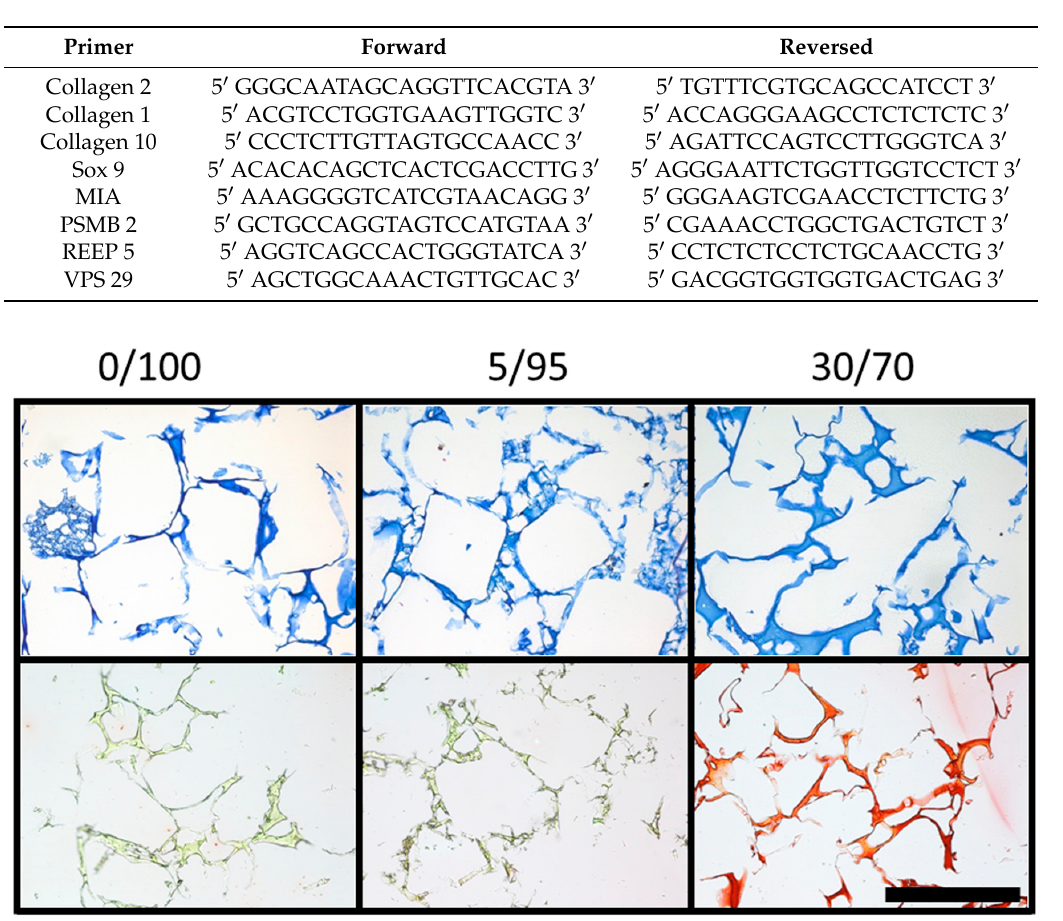
Figure A1. DMMB and picrosirius red staining of empty scaffolds of different composition (columns): DMMB staining for glycosaminoglycans (e.g., HA) at ×10 magnification (upper row) and picrosirius red staining for collagen (e.g., gelatin) content (scale bar = 500 µm). Scaffolds with higher gelatin content are more intensely stained by picrosirius red, while homogenous distribution of the components within the scaffolds is visualized.